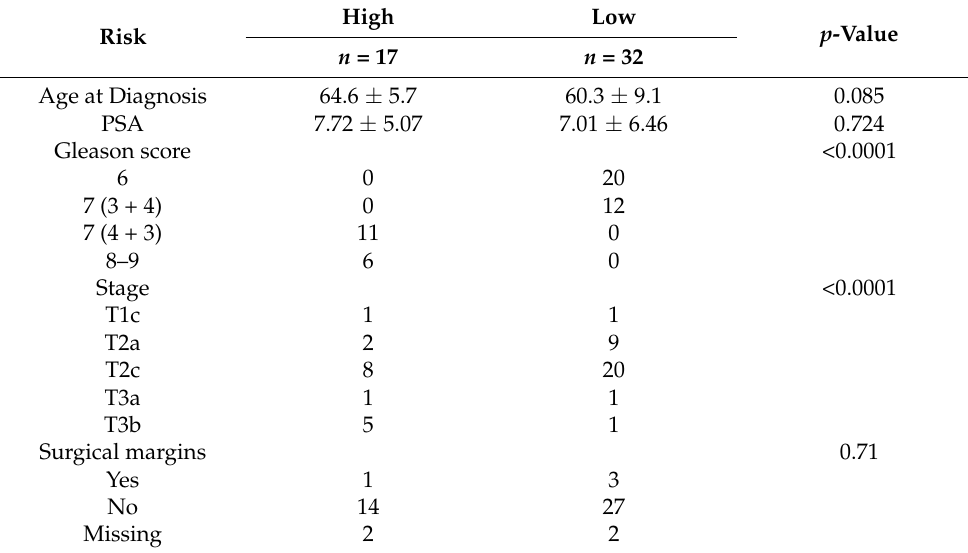
Table 1. Clinicopathological characteristics of Puerto Rican men ( n = 49) with prostate cancer in the pilot